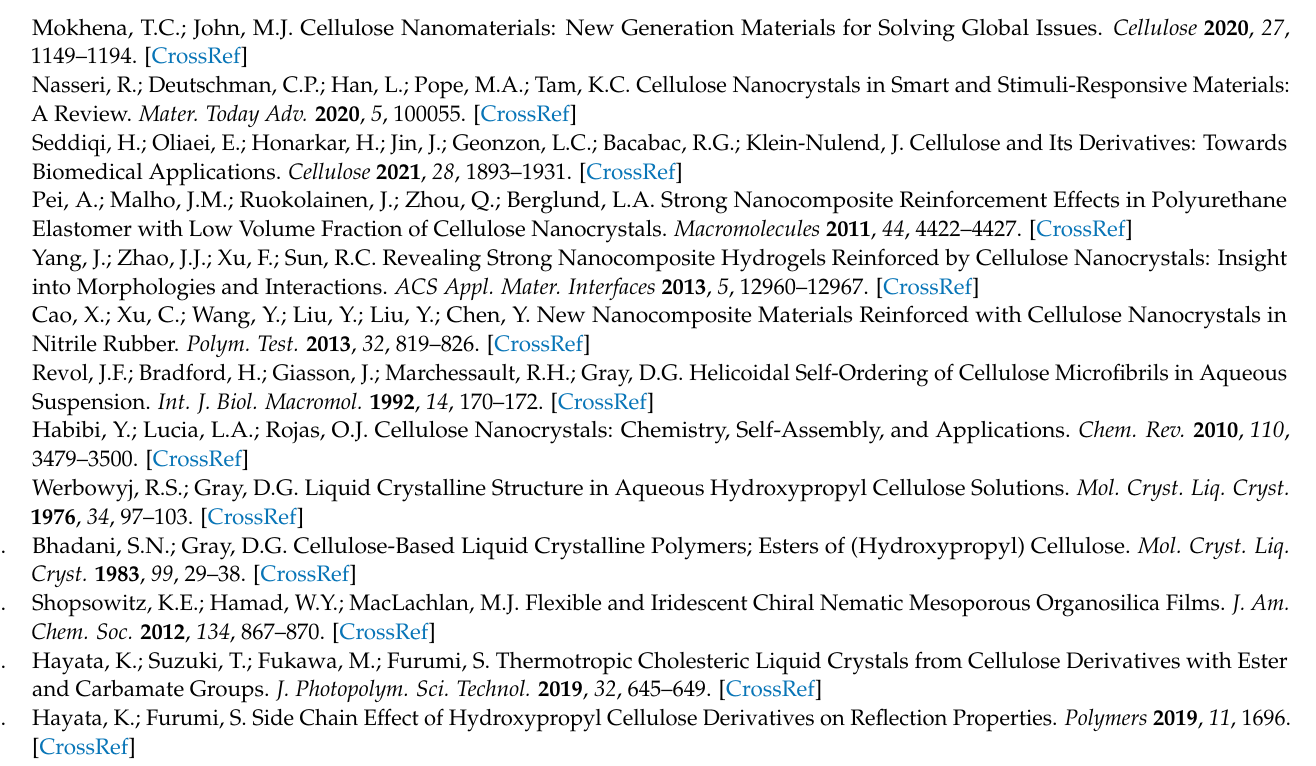
Figure S9: The temperature at which HPC-Pe and HPC-Pe/C n reflect a light at 800 nm; Figure S10: Temperature dependence of the HPC derivatives possessing propionyl groups, butyryl groups, or both; mathematical derivation of XE and CnE of HPC-X/C n